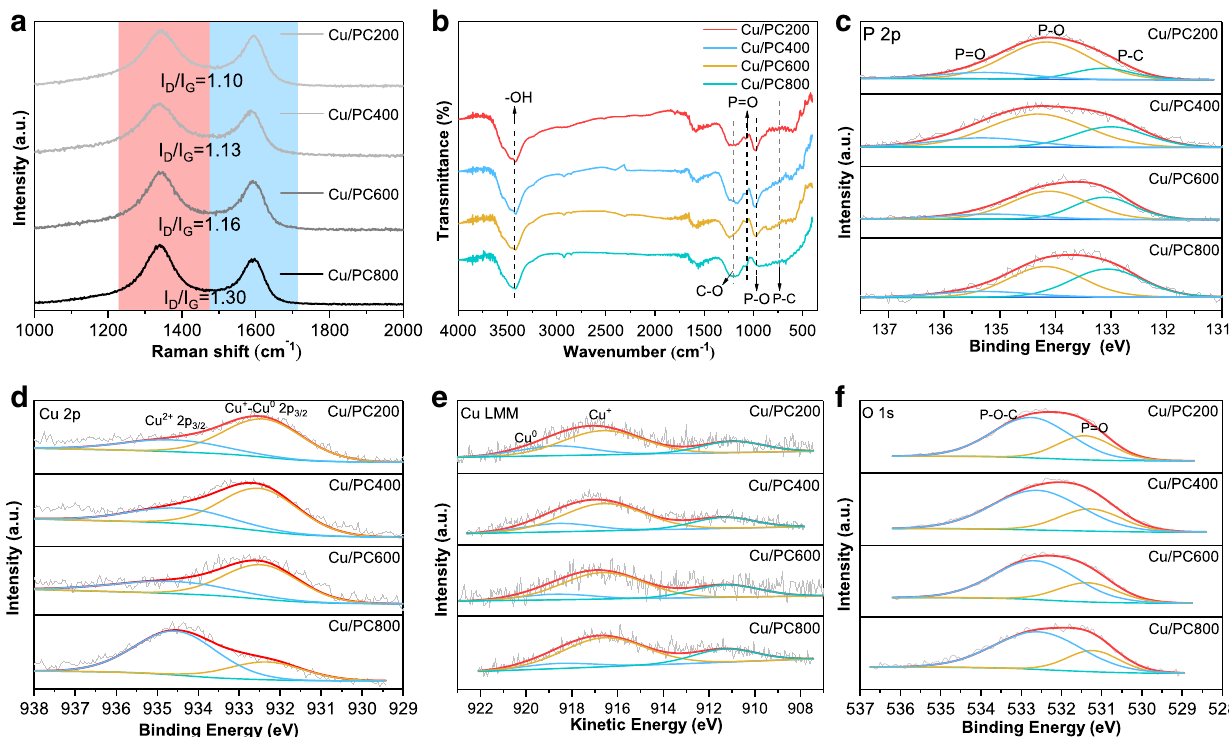
Fig. 3 Characterization of the P-doped Cu-based catalysts. a Raman spectra, b FT-IR spectra, c P 2p XPS spectra, d Cu 2p XPS spectra, e Cu XAES spectra, and f O 1 s XPS spectra of fresh P-doped Cu-based